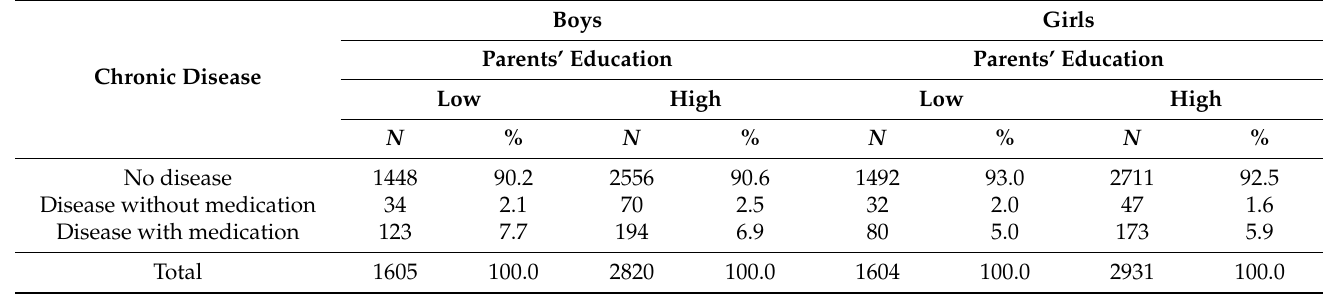
Table A3. Distribution of chronic disease by gender and parents’ education in the seventh grade. Pearson’s